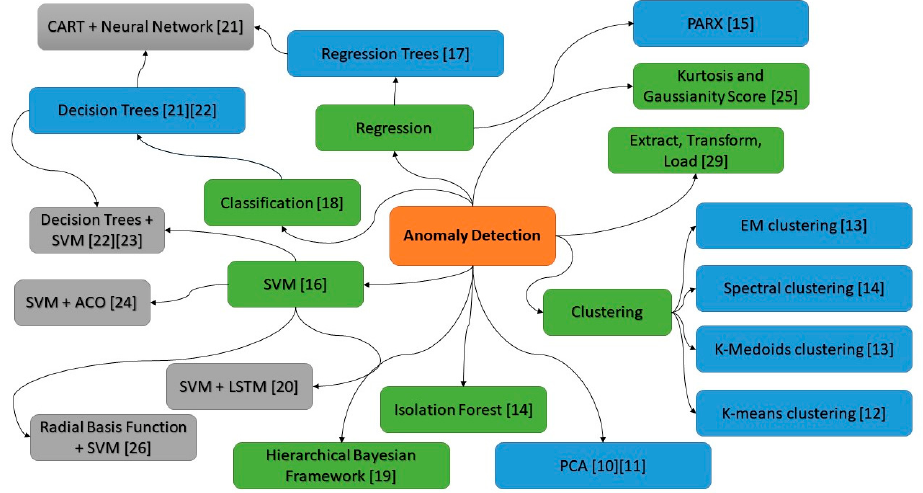
Figure 1. Mind map of the concepts from the literature review used for anomaly detection [10–29].